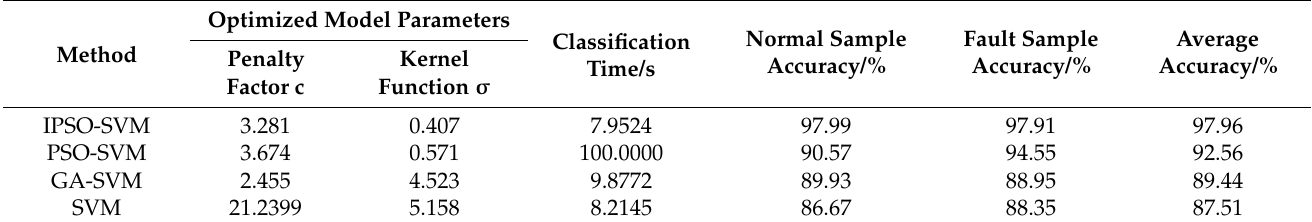
Table 5. The diagnosis results from the fault diagnosis system of the combine